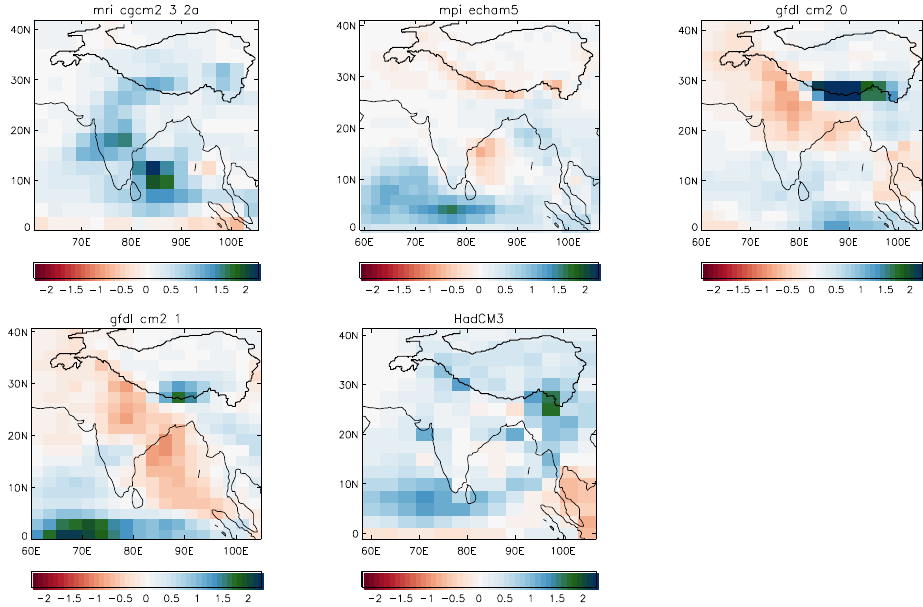
Figure 4. Change in precipitation (mm per day) by the 2080s relative to 1961–1990 under the SRES A1B scenario for four selected CMIP3 Figure 4: Change in precipitation (mm per day) by the 2080s relative to 1961-1990 under the SRES 815 models and a flux-corrected version of HadCM3. The region above 2500ma.s.l. is A1B scenario for four selected CMIP3 models and a flux-corrected version of HadCM3. The region 816 above 2500 m a.s.l. is indicated. 817